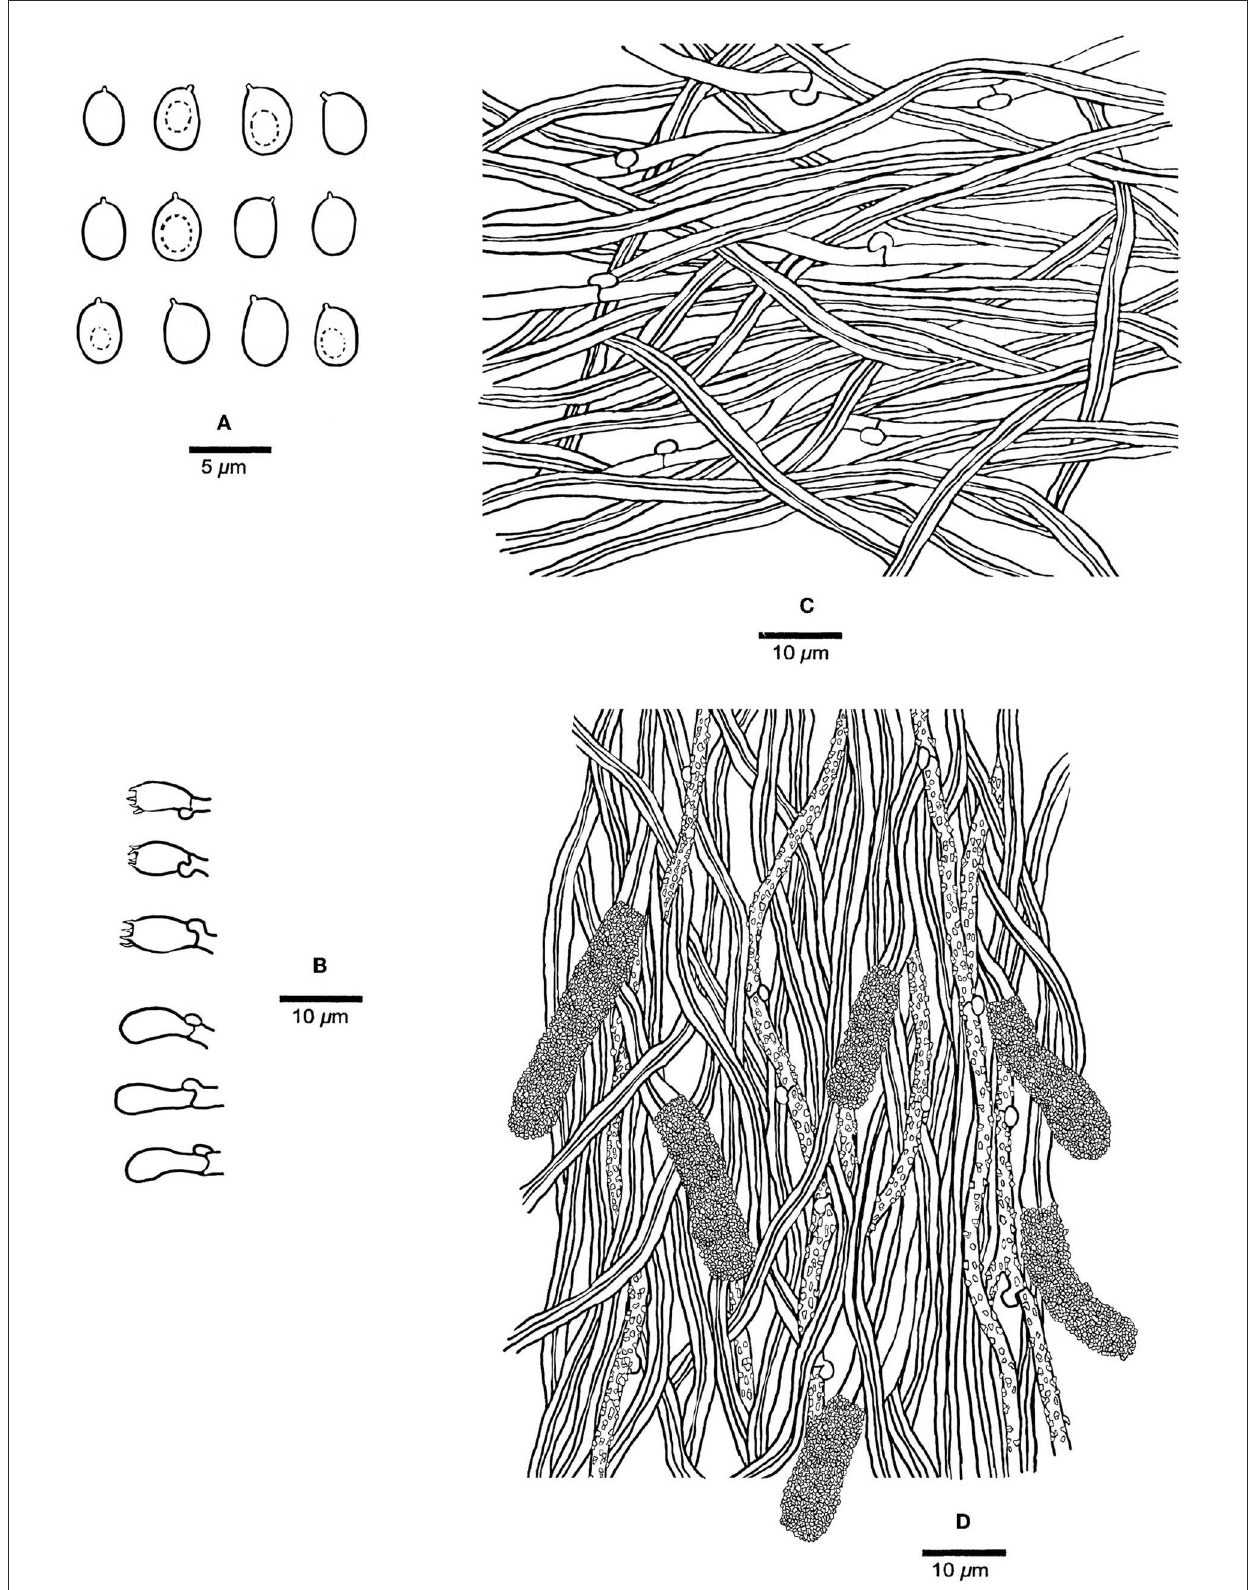
FIGURE3 Microscopic structures of Steccherinum incrustans (Holotype, Dai 19442). (A) Basidiospores. (B) Basidia and basidioles. (C) Hyphae from subiculum. (D) Skeletocystidia and hyphae from trama. Drawn by Meng